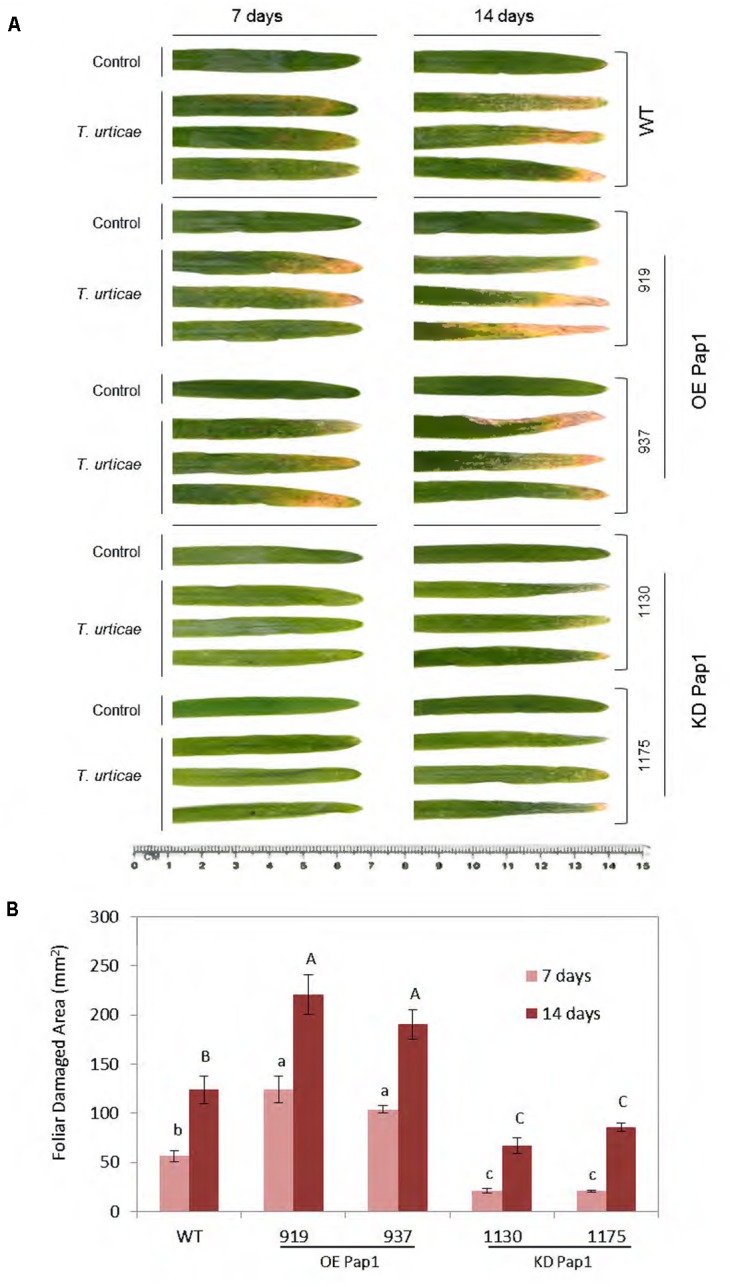
Images of the oldest leaf of transgenic and wild-type barley lines during T. urticae attack, along 7 and 14 days of infestation or non-infestation as control. (A) Leaves from HvPap-1 overexpressing lines (OE Pap1, 919 and 937), silencing lines (KD Pap1, 1130 and 1175) and wild-type (WT) plants. (B) Quantification of leaf damage on barley transformed (OE Pap1 and KD Pap1) and non-transformed (WT) plants, after 7 (light red) and 14 (dark red) d of T. urticae infestation. Damage was measured as mm2 of injured foliar area and is represented as mean ± SE of seven old leaves measurements from seven independent plants per treatment. Different letters indicate significant differences (P < 0.01, one-way ANOVA Student Newman–Keuls SNK test).